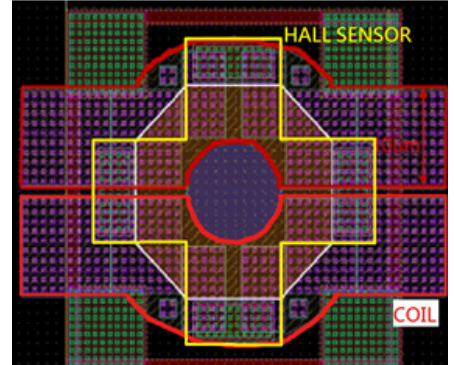
Figure 3. Layout of Hall sensor area (yellow) and induction coil